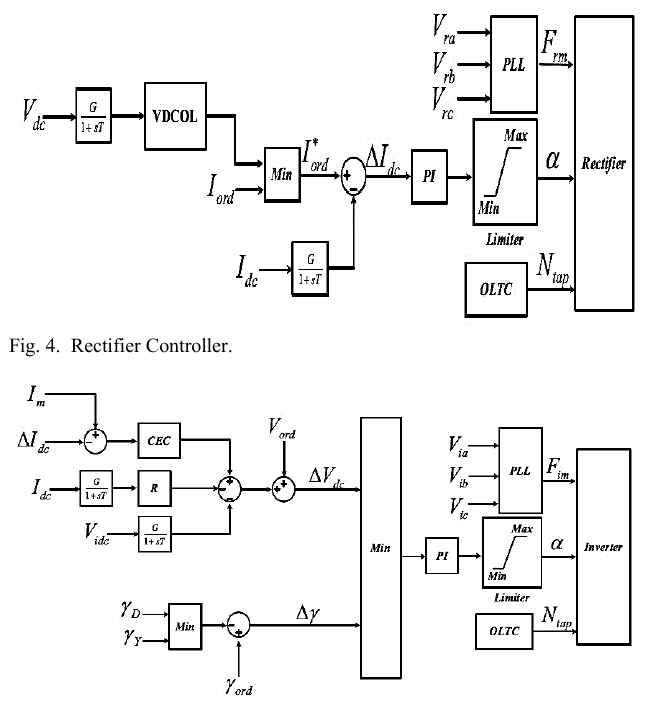
Fig. 5. Inverter Controller.